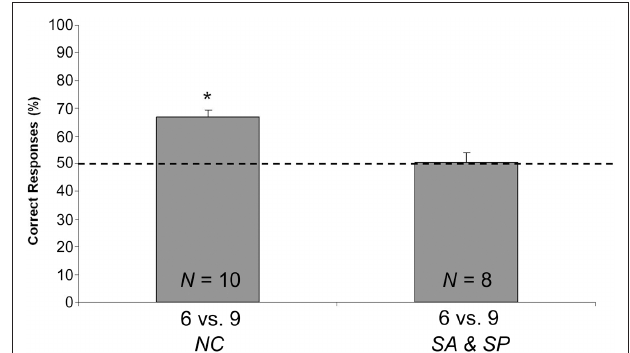
Figure 3 | results of exp. 1. Percentages of correct responses (group means ± SEM) scored by chicks that underwent the no control test (NC) or both the control tests: same area (SA) and same perimeter (SP). The dotted line ( y = 50) represents